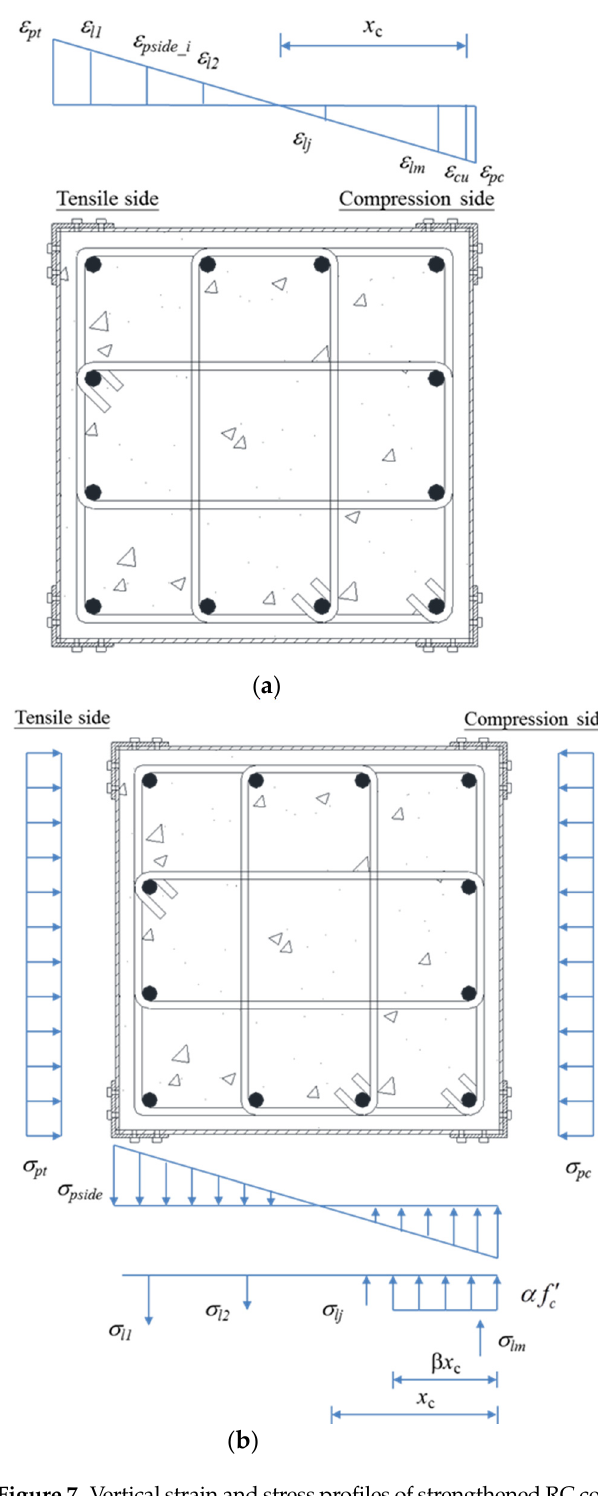
Figure 7. Vertical strain and stress profiles of strengthened RC column: ( a ) strain profile; ( b ) stress profile.